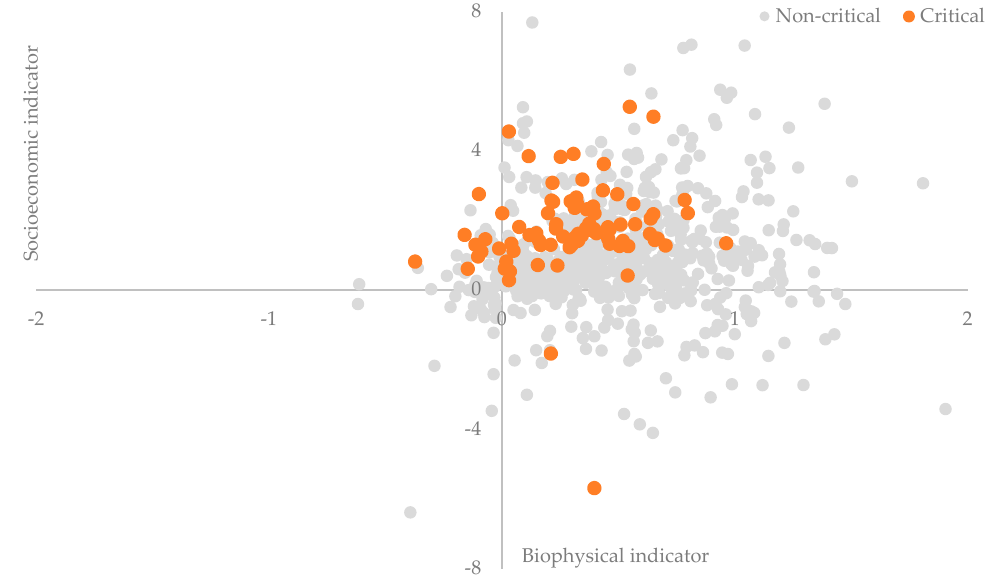
Figure 4. Per cent rate of change over time (from the Early-1990s to the Early-2010) in two indicators of soil sensitivity to degradation in homogeneous agricultural districts of Italy, distinguishing between critical and non-critical districts (biophysical indicator >0.5 or <0.5 in the early 2010s).